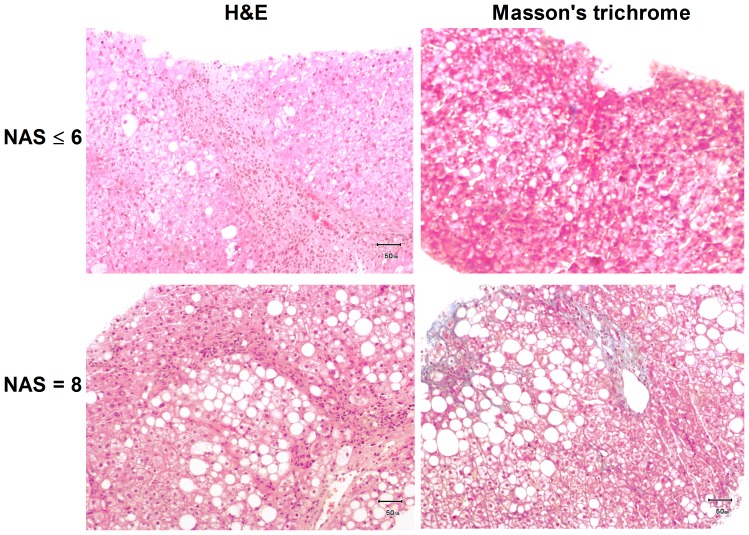
Histological liver representation of parenteral nutrition-associated liver disease patients.Hematoxilin & eosin and masson's trichrome staining of liver biopsies taken for diagnosis purposes. The images are representative of patients with non-alcoholic liver hepatic disease score (NAS) ≤6 and patients with NAS>6 who initiated Omegaven® treatment.